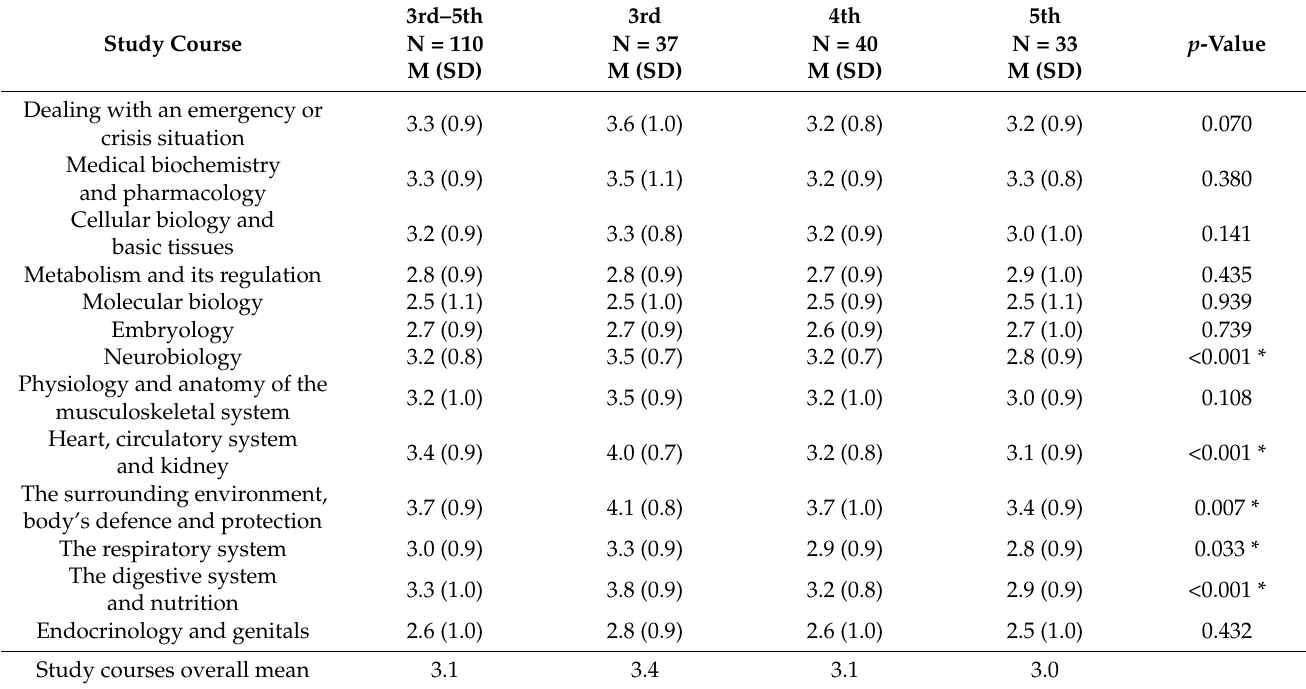
Table 2. Students’ responses to the question asking them to evaluate how common biomedical courses had laid the foundation for dental clinical courses. Mean values (M) and standard deviations (SD) of the course evaluations.